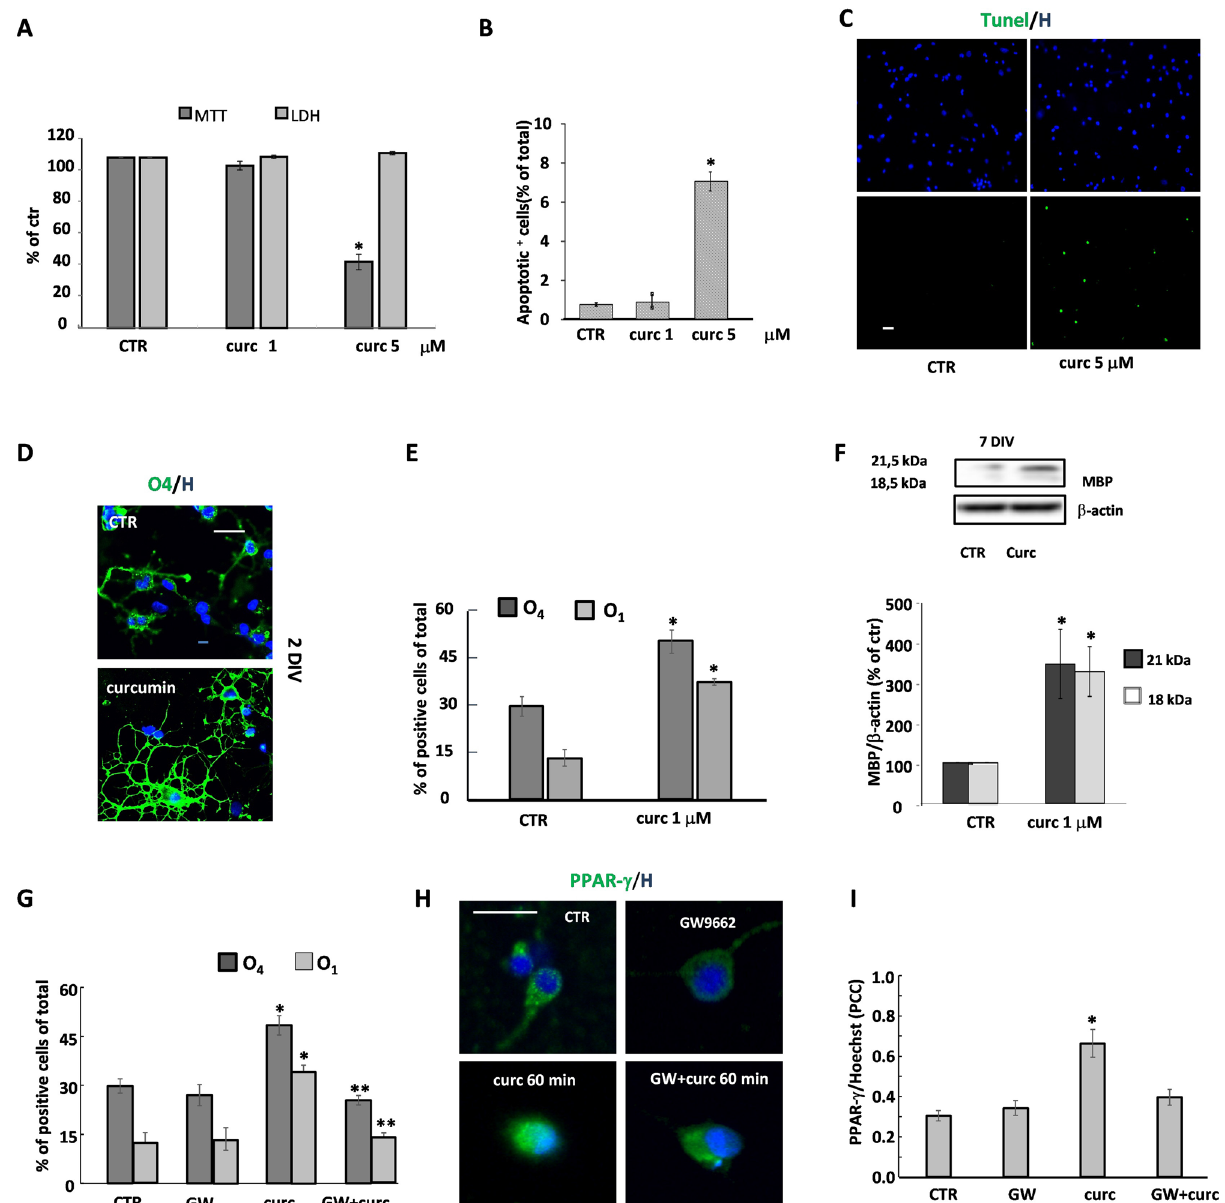
Figure 1. Effects of curcumin on OP viability and differentiation. The effects of 24 h treatment with curcumin (curc, 1 or 5 μM) on OP viability were examined using the MTT assay and the LDH level production. The values (means ± SEM) from 3 to 5 independent experiments run in triplicate are shown in ( A ). The number of apoptotic cells was evaluated in OP cultures exposed to 1 or 5 μM curcumin. Total cell numbers were assessed by staining with Hoechst 33258 vital dye and apoptotic cells were identified by nuclear morphology ( B ) or by Tunel assay (green labelling, C ). Data of both tests are included, and the percentages of total cell number in each condition are showed. Labelled cells were counted in 6 to 10 coverslips from 3 to 5 independent experiments ( B ). *p < 0.0001 vs CTR. After 24 h of curcumin treatment (1 μM), OPs were immunostained for the two developmental markers O 4 and O 1 . Nuclei were marked using the Hoechst 33258 (H). Panel ( D ) shows O 4 (green) and H (blue) labelling. Cells were counted and percentages of Â± O 4 - and O 1 -positive cells are shown in ( E ). Data are mean SEM of 10 microscopic fields per coverslip prepared in duplicate from 3 to 5 independent experiments. At 7 DIV ( F ) the expression of MBP was evaluated by western blot analysis. Representative western blot of two isoforms (18 e 21 kDa) of MBP and β-actin are shown (top panel in F ). Bar graphs show the quantitative evaluation of MBP/β-actin expression ratio of both isoforms from three different experiments (bottom panel in F ). To verify the involvement of PPAR-γ, OPs at 1 DIV were treated for 24 h with curc (1 μM) in the presence or absence of the PPAR-γ antagonist GW9662 (GW) (1 μM) and the percentages of O 4 and O 1 positive cells were evaluated ( G ). Data are mean ± SEM of 3 to 5 independent experiments * p < 0.001 versus CTR, ** p < 0.001 versus curc. The translocation of PPAR-γ in the presence/absence of curcumin and GW9662 was evaluated by immunofluorescence. Panel ( H ) shows PPAR-γ (green) and H (blue) labelling. The colocalization of PPAR-γ and Hoechst fluorescence signal was evaluated by Pearson’s correlation coefficients (PCC) where PCC = 1 corresponds to maximal colocalization. Data are mean ± SEM of 3 independent experiments. Scale bar = 30 µm. Image Lab 4.0 software (Bio-Rad, http://www.bio-rad.com/ en-us/sku/17096 90-image -lab-softw are) and Leica Application Suite Software (260RI, https: //www.leica -micro syste ms.com/produ cts/ micro scope -softw are/detai ls/produ ct/leica -las-x-ls/) were used respectively for Wb and IF image